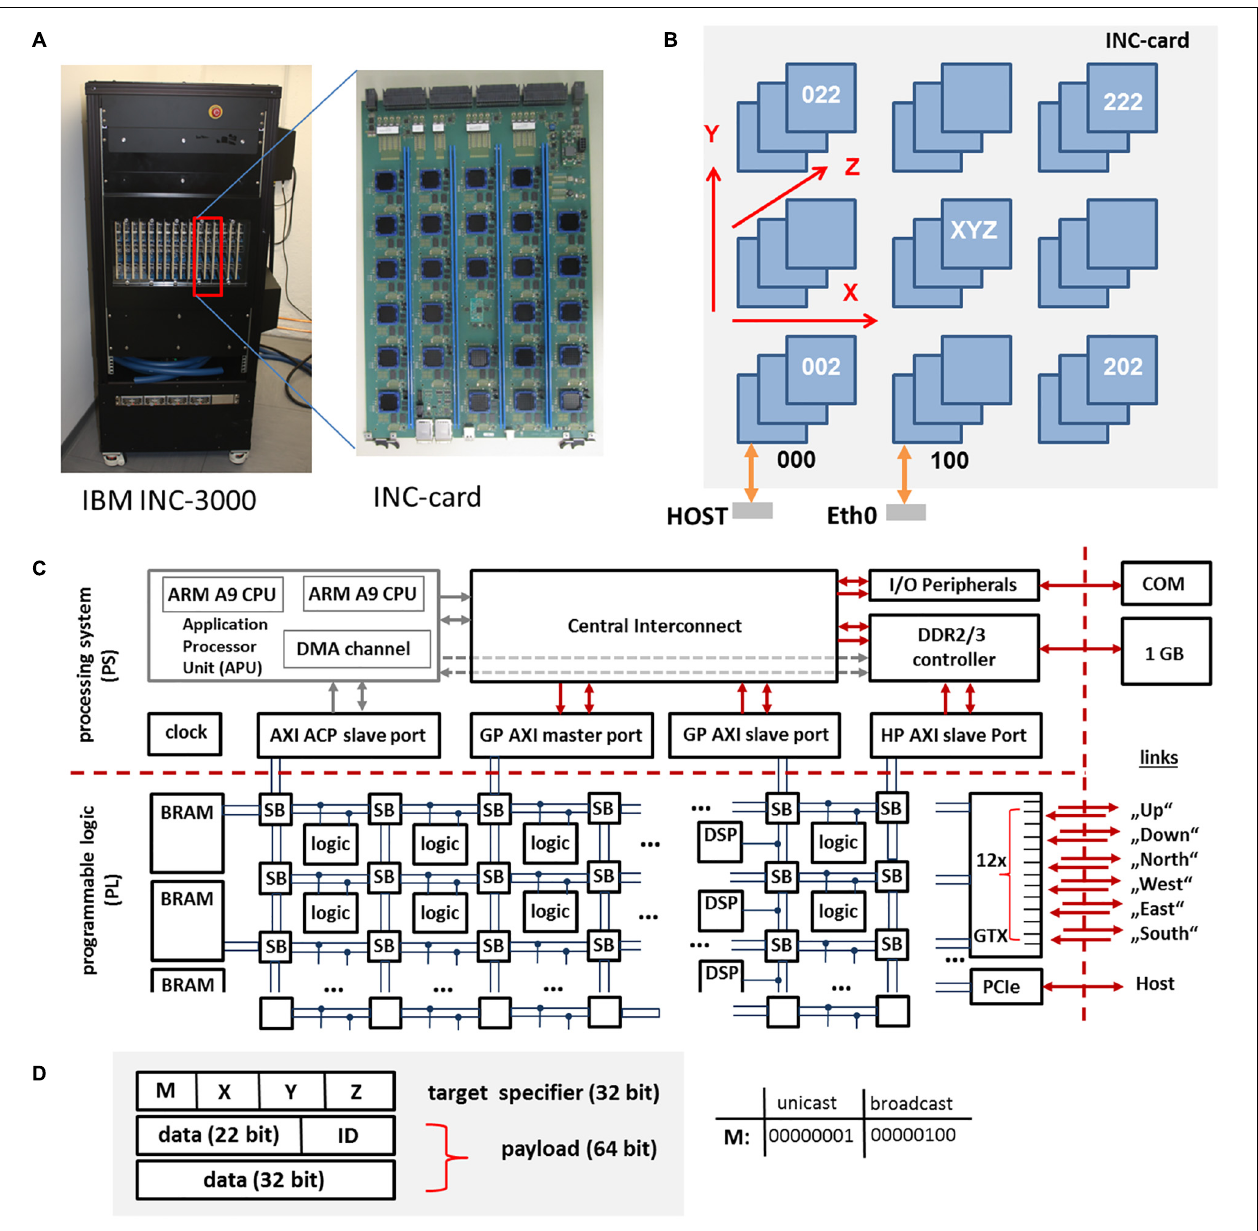
FIGURE 2 | INC-3000 system featuring 16 INC cards (A) , each card (B) is equipped with 27 FPGAs. The whole INC-system represents a 12 × 12 × 3 3D-node mesh. The architecture of the Xilinx XC Z7045 SoC is shown in (C) . The programmable logic (PL) is based on a fabric of configurable logic blocks, DSPs, and block RAMs (BRAM). The packet format (96 Bit) is shown in (D) . A packet consists of a 32-bit target specifier and a 64 bit payload. The triplet ( X, Y, Z ) specifies the logical coordinate of the target node (unicast mode). The ID-field specifies the packet